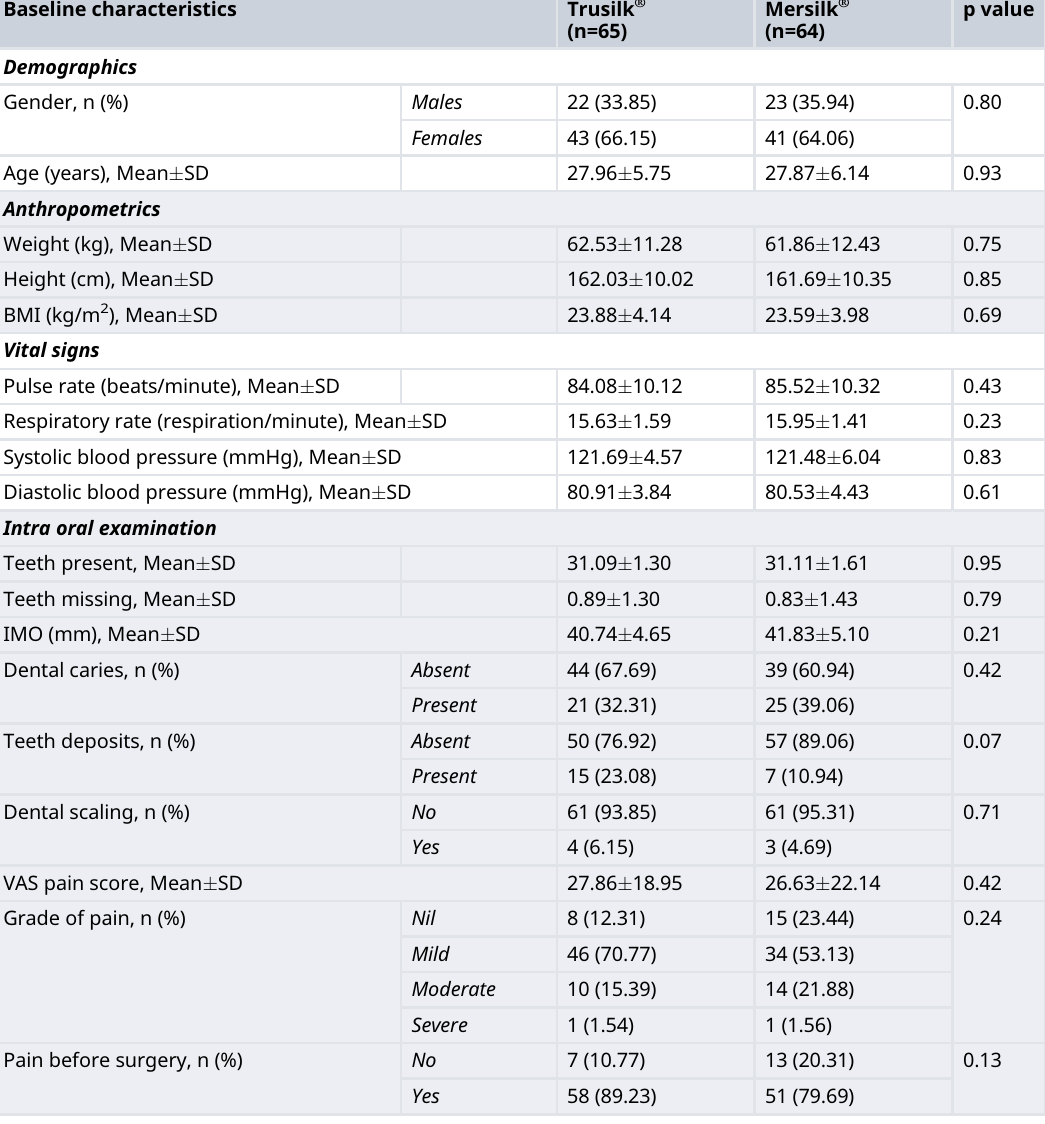
Table 1. Baseline demographics and intra oral characteristics of the study participants. Baseline